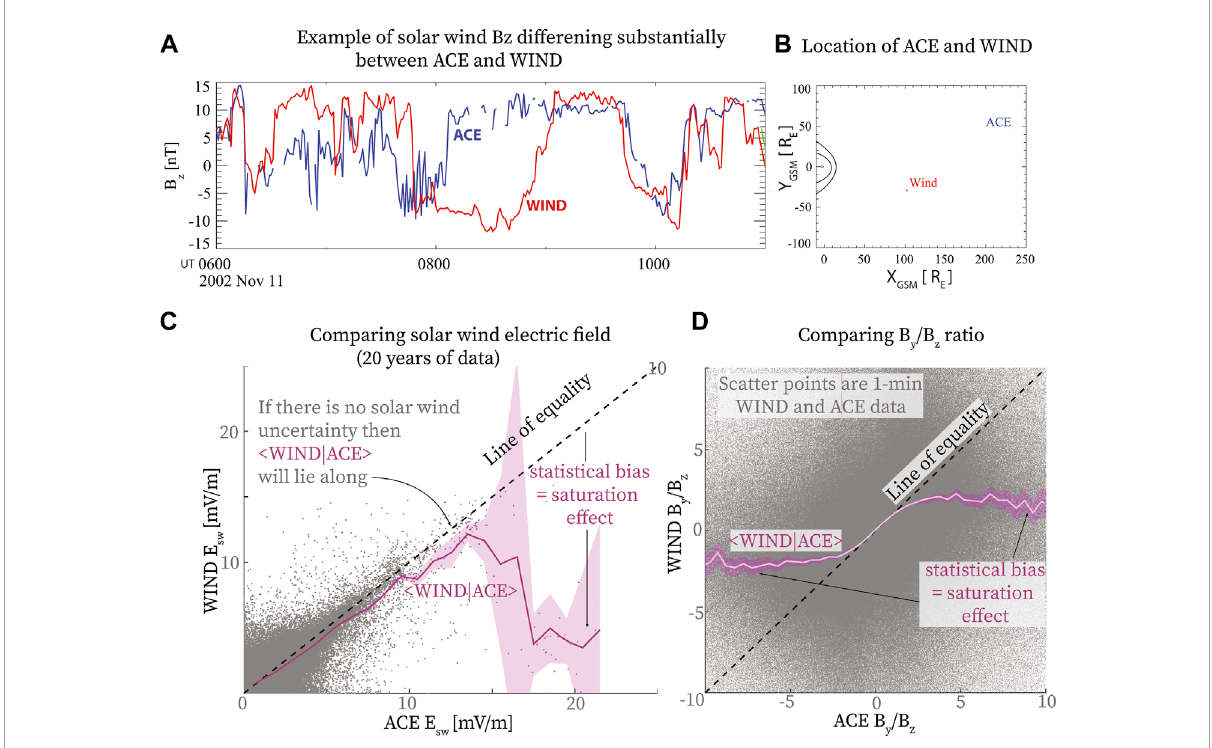
FIGURE 2 Solar wind measurements at L1 are an uncertain measure of the solar wind that affects the magnetosphere. (A) Northward component of solar wind magnetic field time-shifted to the nose of the bow shock based on measurements from ACE and Wind, (B) spacecraft positions in the ecliptic plane. (C) Comparing solar wind electric field measured by Wind and ACE. Solar wind uncertainty statistically biases the average Wind measurements to lower values than the corresponding ACE measurements. Without measurement uncertainty, the result would lie along the “Line of equality.” The bias creates an appearance of Wind measurements saturating with increasing ACE measurement on average. (D) Comparing the ratio of IMF By and Bz estimated from Wind and ACE measurements. Adapted from Sivadas and Sibeck